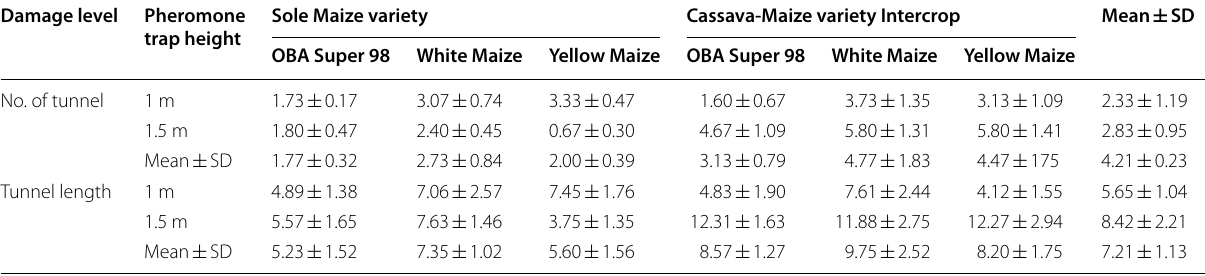
Table 2 The mean SD effect of cropping pattern and maize variety on the number of tunnels and tunnels length ± caused by Fall Army Worm on maize cultivated in the Niger Delta Region of Nigeria under two pheromone trap heights as a means of determining population dynamics Damage